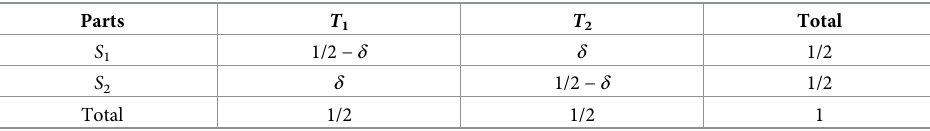
Table 6. Model confusion data for